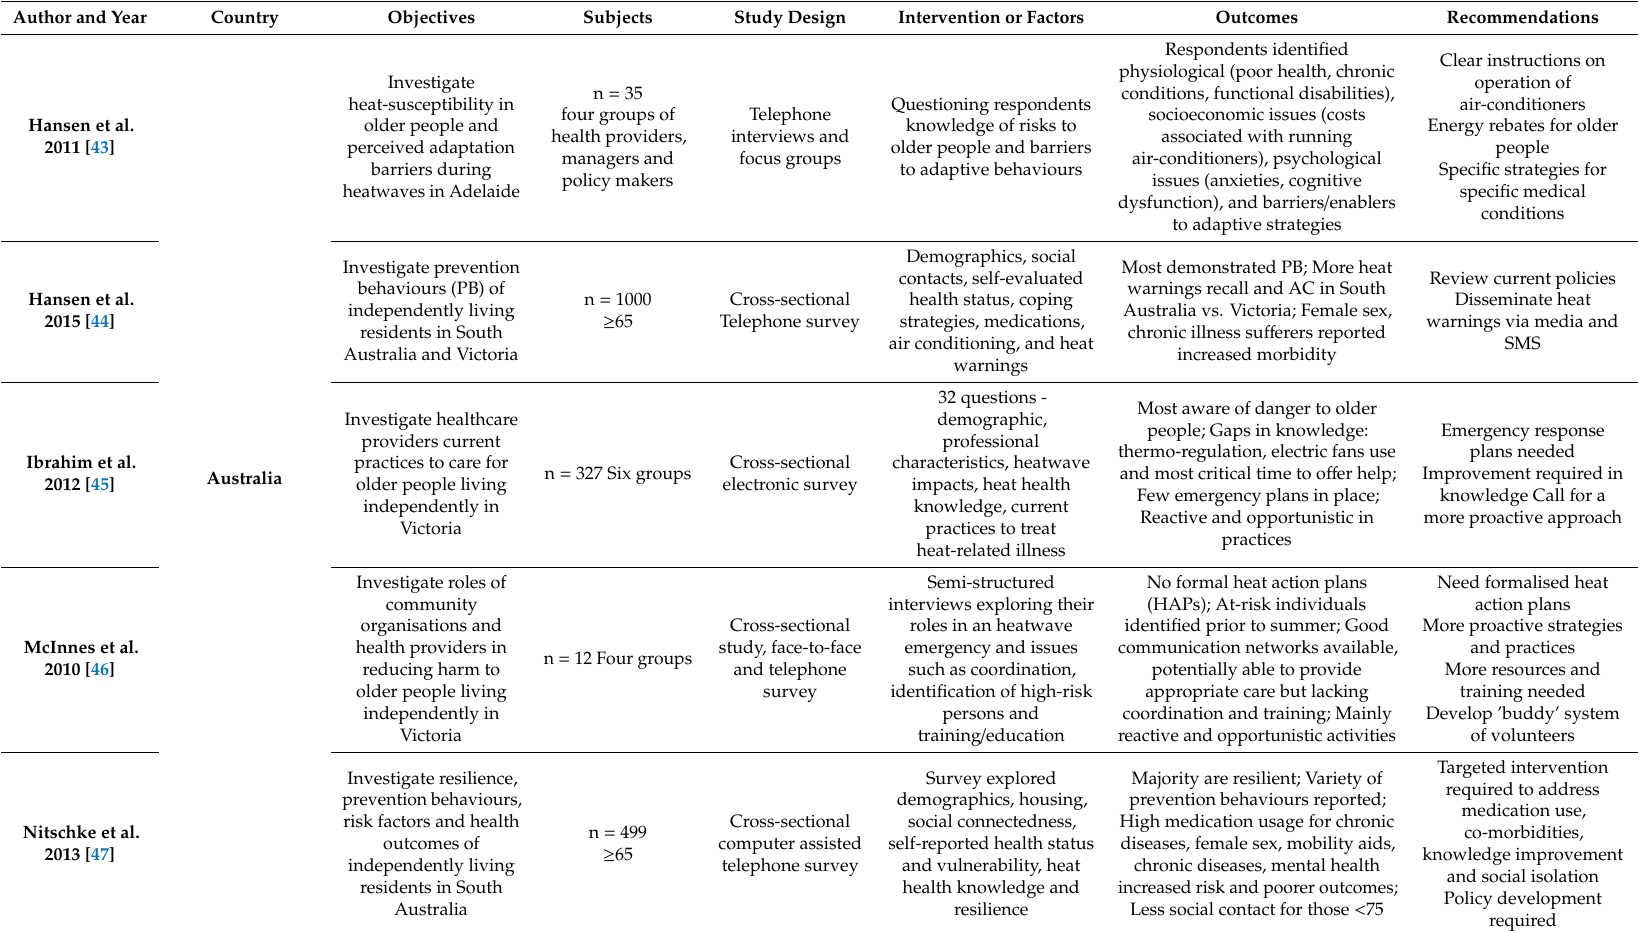
Table 2. Summary of selected